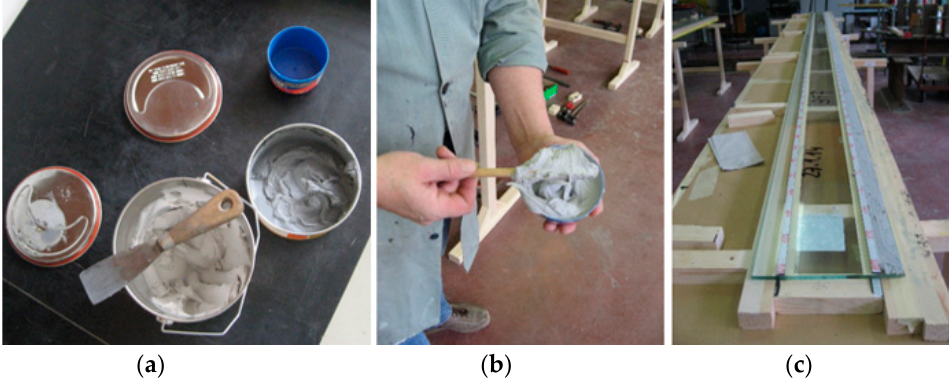
Figure 13. ( a ) Epoxy Sikadur®-31 CF Normal component A—white and component B—grey; ( b ) shows the mixture of the two components of the epoxy adhesive; ( c ) application of the epoxy adhe- sive to the glass.